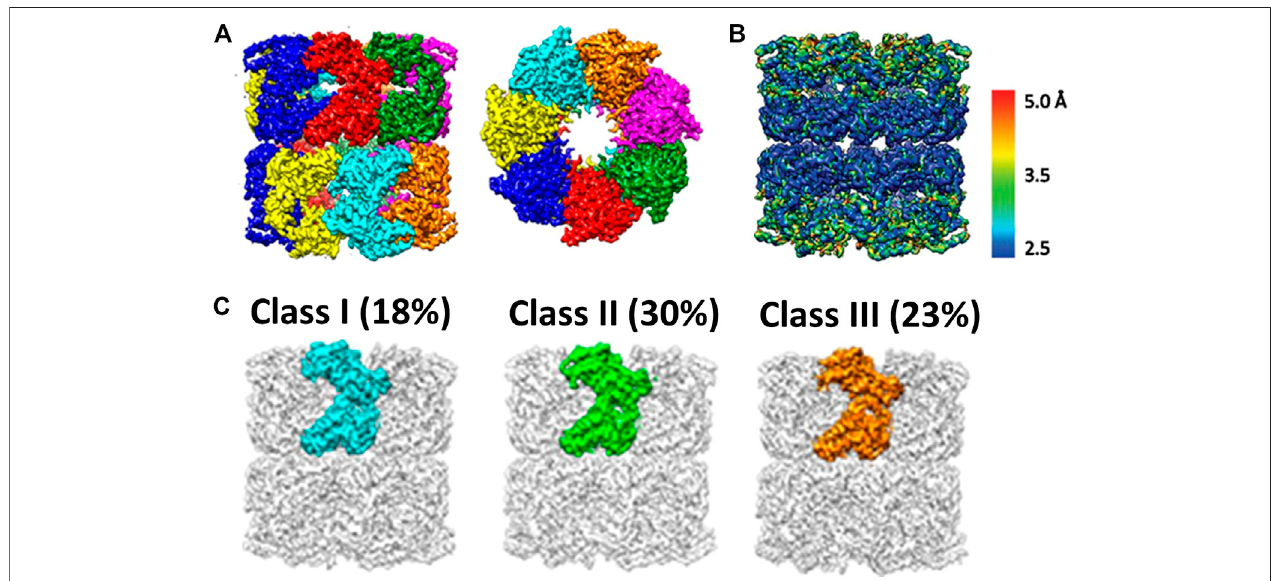
FIGURE5| Cryo-EManalysesofGroEL,amulti-subunitproteinmachinery. (A) Segmentationofahigh-resolutioncryo-EMreconstruction.Thisallowsextractionof individualsubunitforfurtheranalysis. (B) LocalResolution mapofGroEl.Itshowstheapicaldomainappearstobemoredynamicascomparedtoequatorialdomain. (C) Focused 3D classi fi cation on individual subunit. It reveals three major conformers (This set of fi gures is adopted from Roh et al (2017) with permission granted by NAS).